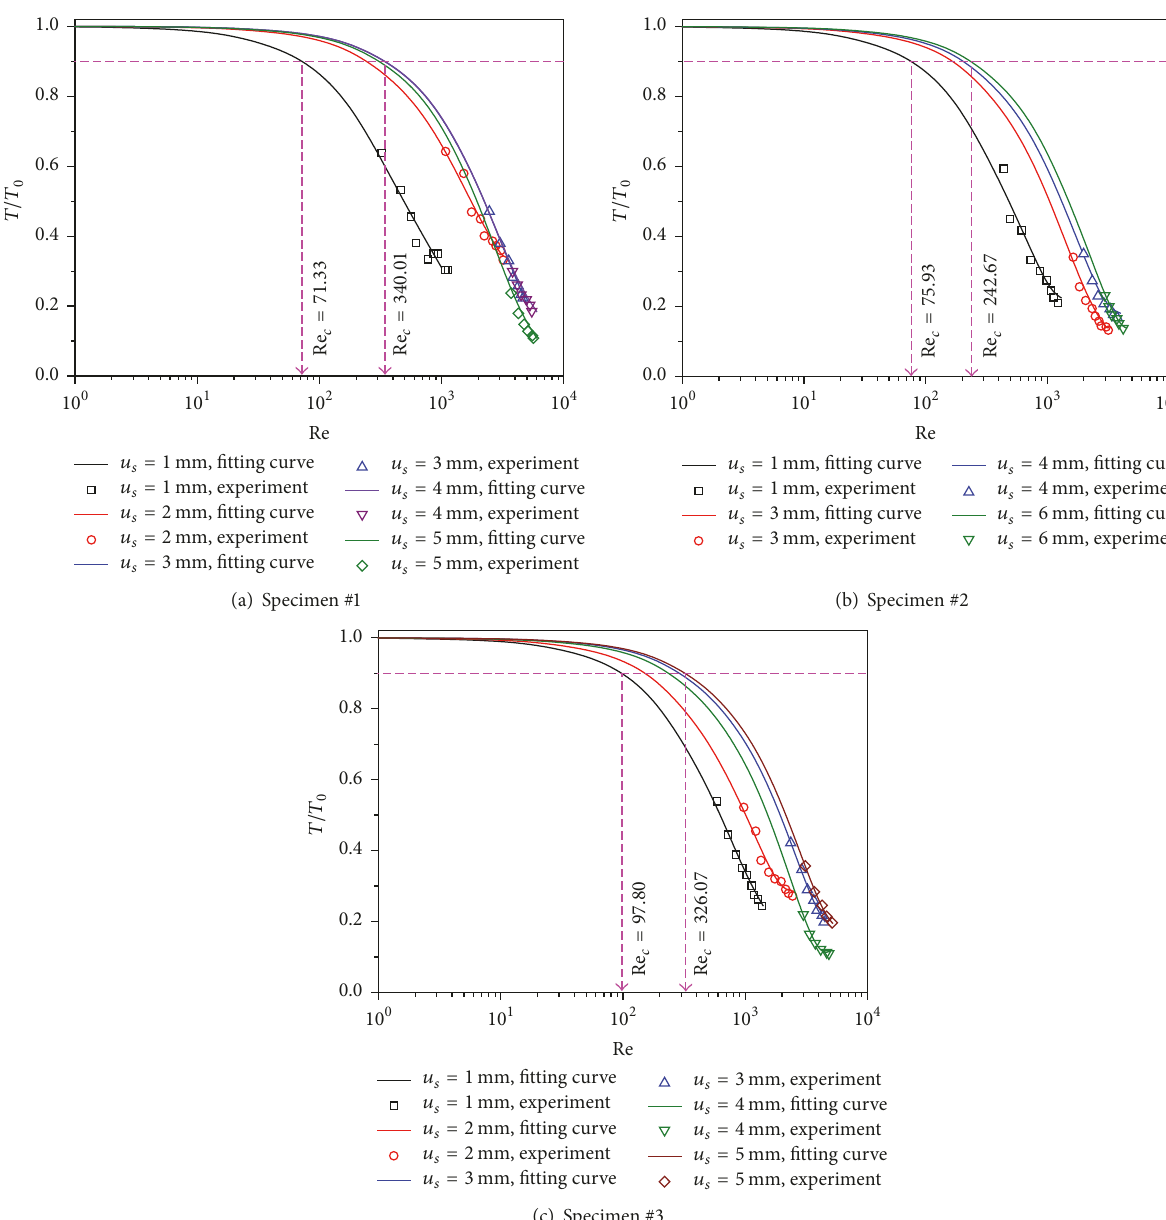
Figure 3: Relationships between T / T 0 and Re based on the data replotted from Xia et al. ([81], Figure 10